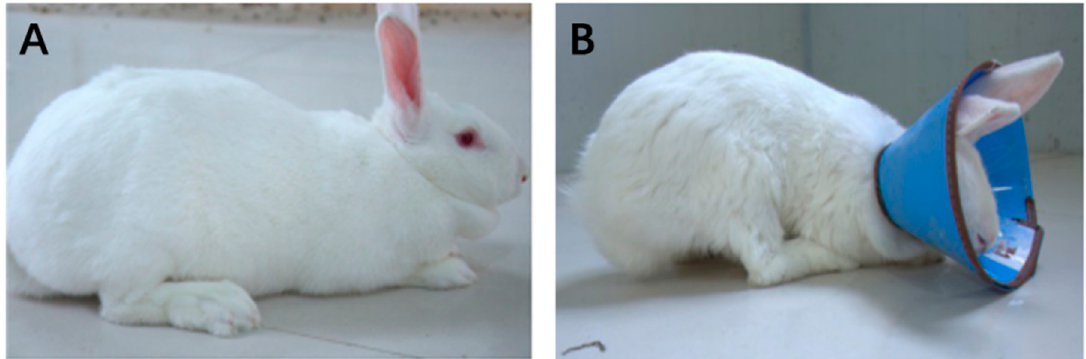
Figure 2. Rabbits in the two groups. ( A ) Control group; ( B ) Experimental